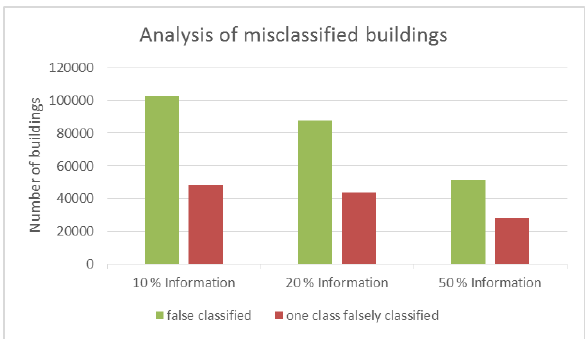
Figure 6. Analysis of misclassified buildings for Ordinary Kriging